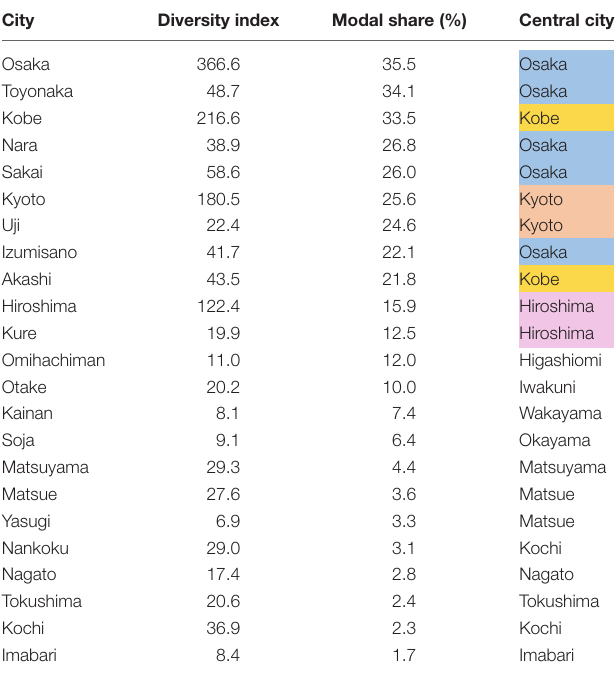
TABLE 1 | Cities listed in descending order of the modal